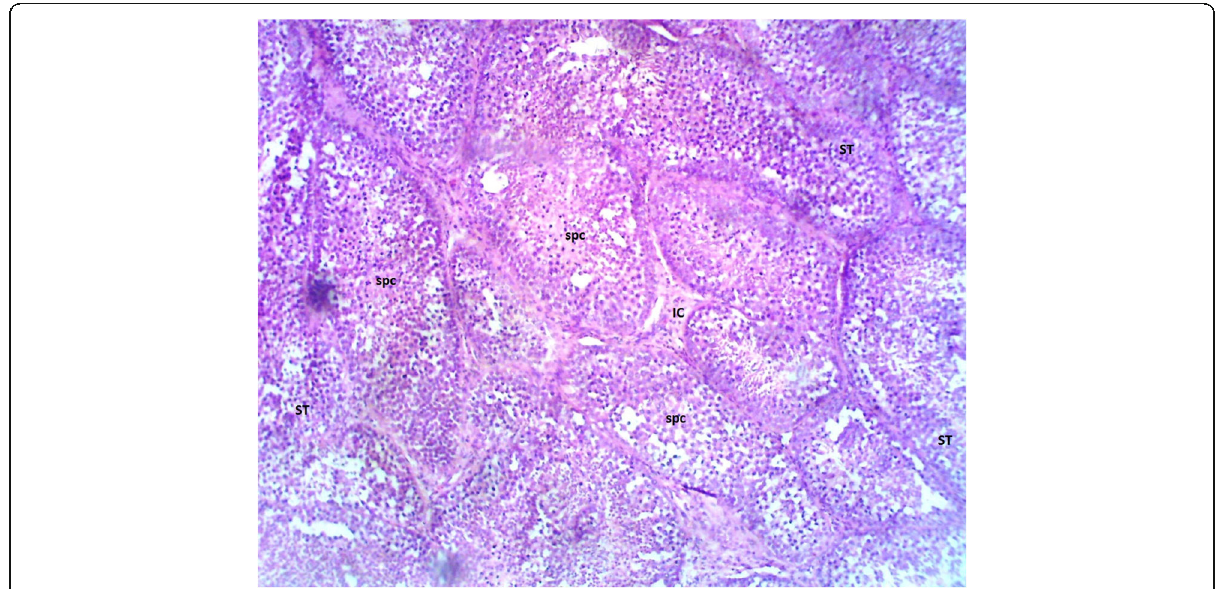
Fig. 8 Representative micrograph of testis section (× 400) of broiler chicks fed 0.2% PCM supplemented diet. This section appears as in Fig. 7 above. SPC sperm cells, ST seminiferous tubules, IC interstitial